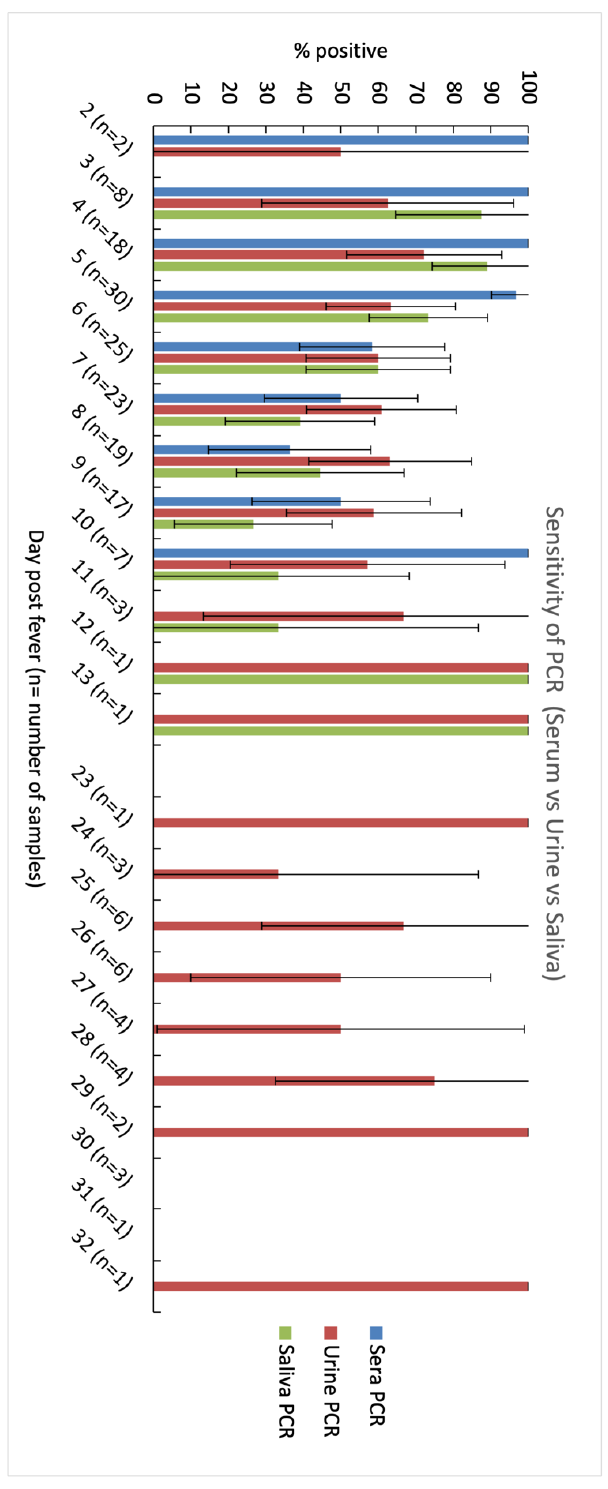
Figure 1. Comparative daily analysis of dengue viral RNA in serum, urine and saliva samples using semi-nested DENV PCR. DENV RNA was detected in urine samples up to 32 days of fever, compared with up to 30 days and 10 days in saliva and serum samples, respectively. n is the number of patients in each day. The whiskers represent 95% CI for each sample.